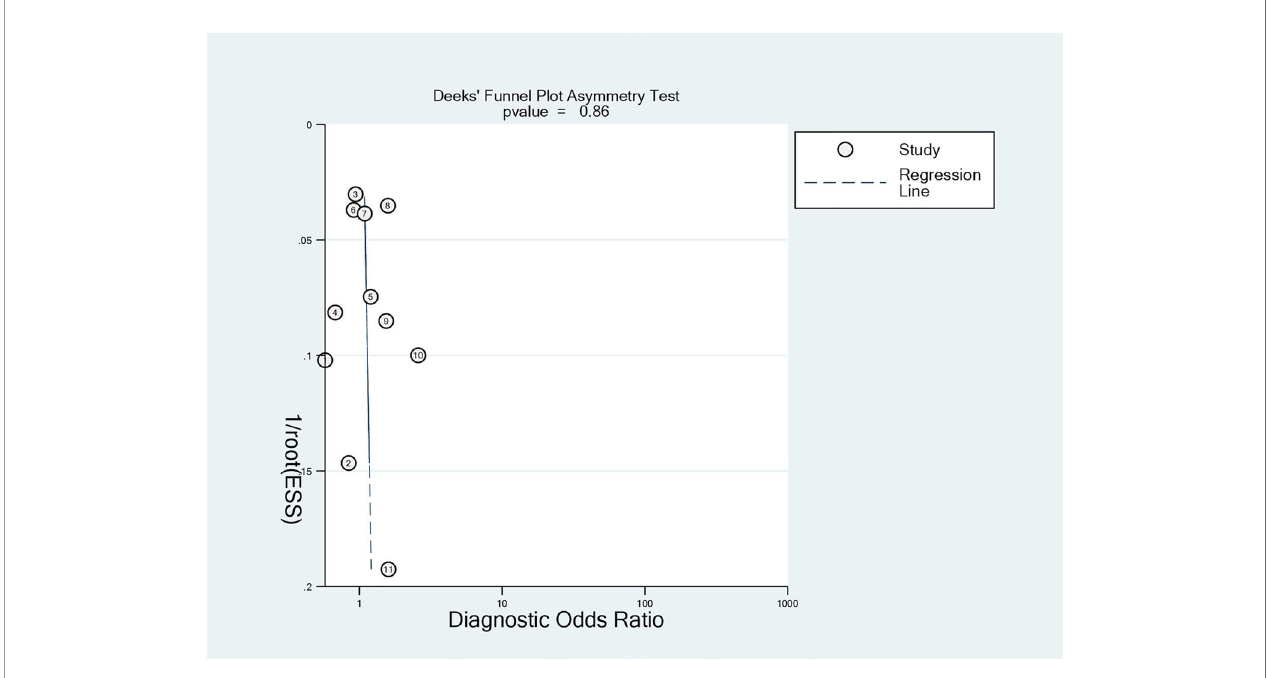
FIGURE 6 | Deeks funnel for publication of included studies.